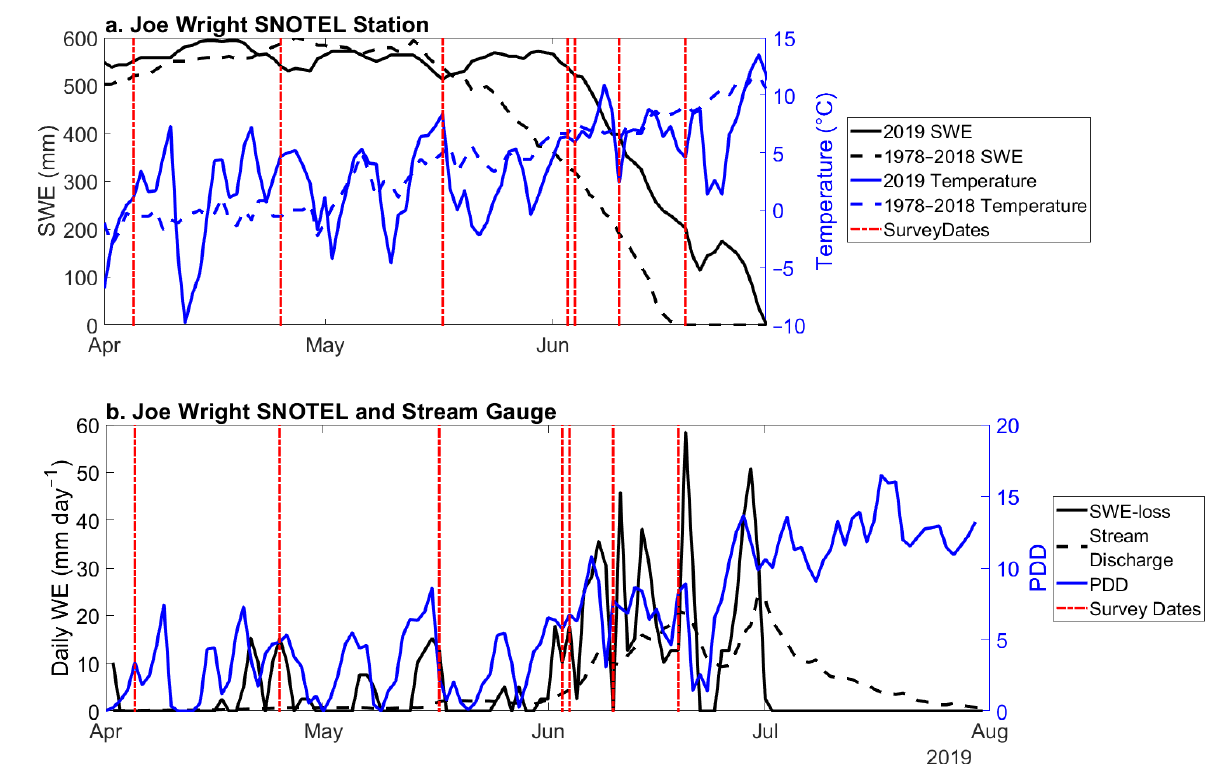
Figure 7. ( a ) Joe Wright SNOTEL station 2019 daily observations of SWE and average air temperature, compared with 1978–2018 daily averages. ( b ) Joe Wright SNOTEL station 2019 hourly air temperatures, converted to PDD, compared with SWE loss from Joe Wright SNOTEL station and stream discharge from Joe Wright Creek stream gauge, converted to water equivalent (WE). Michigan Ditch stream gauge data was subtracted from Joe Wright Stream gauge to remove regulated